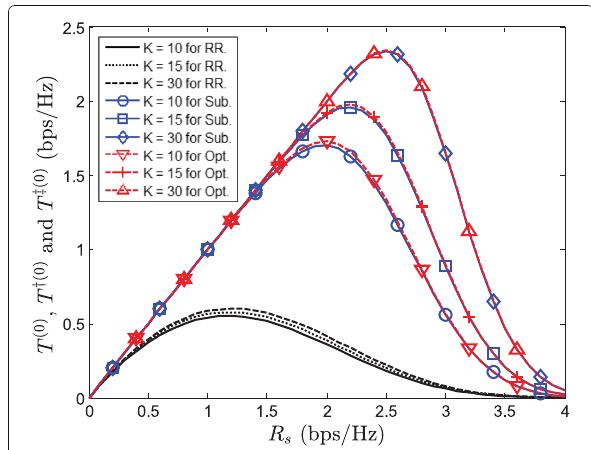
Fig.5 Impacts of multi-user diversity on best-case-EST for round-robin scheme (RR.), suboptimal scheme (Sub.), and optimal scheme (Opt.)